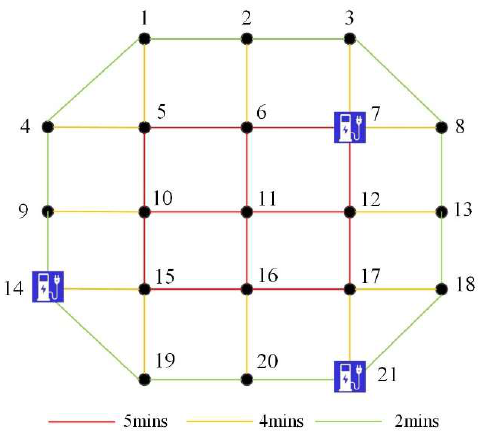
Figure 6. Schematic diagram of the 21-node transportation network. Table 1. Coupling nodes in transportation and distribution network.